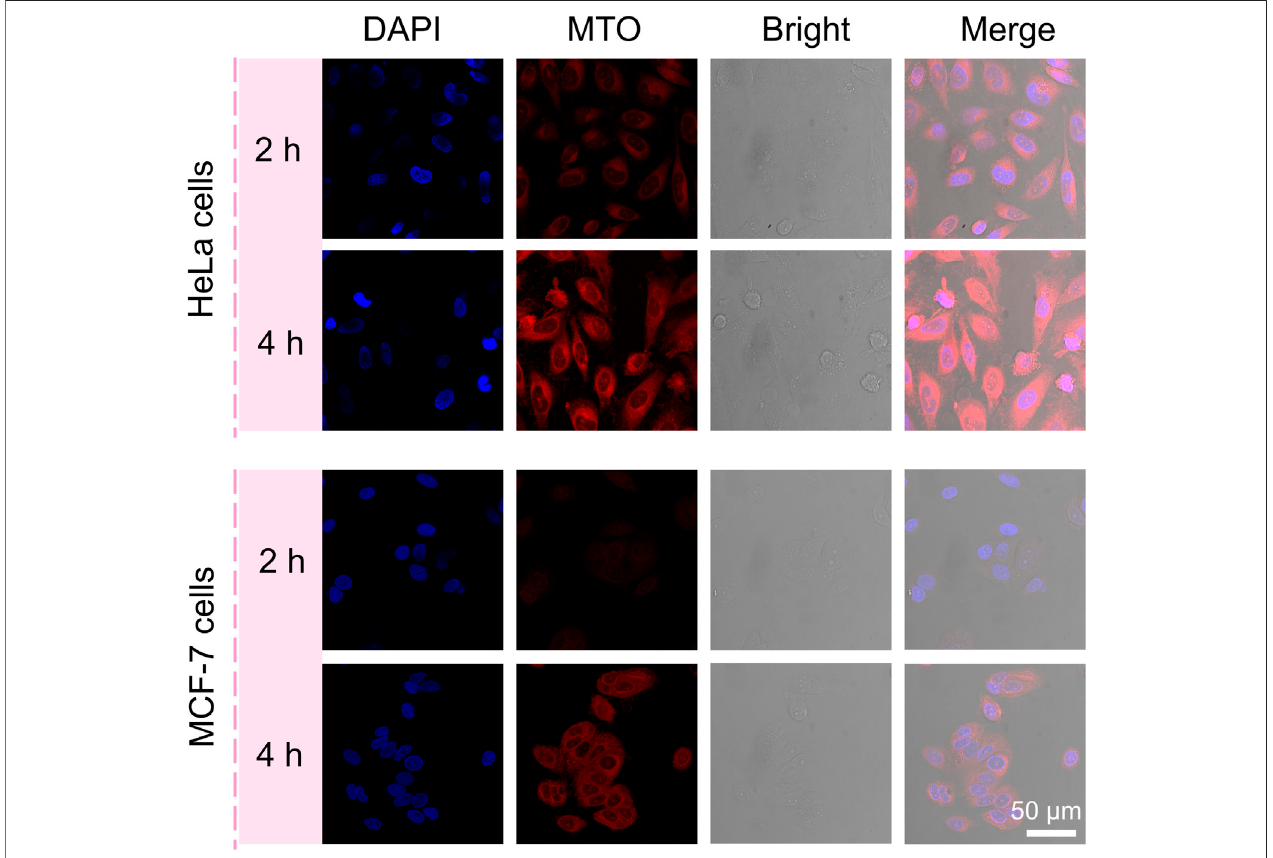
FIGURE 5 | CLSM images of the HeLa cells and MCF-7 cells incubated with MC NRs for 2 or 4 h showing the internalization ef fi ciency of the MC NRs, where the nuclei were counterstained with